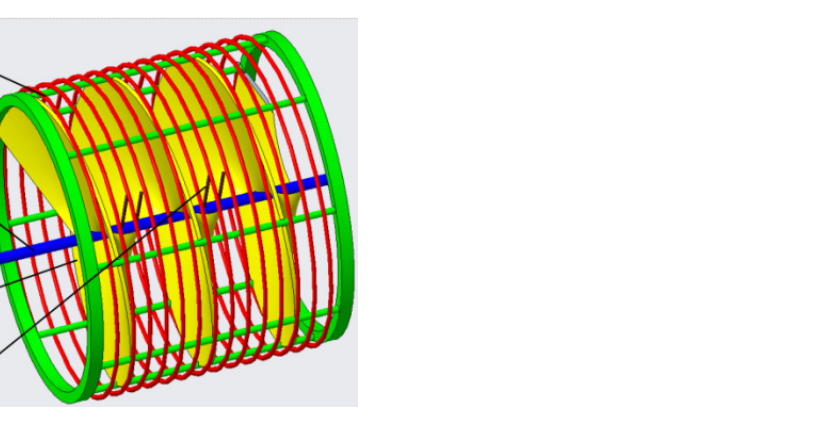
Figure 2. Flexible separation device for fruit–soil structure diagram. 1. Ring; 2. Drive shaft; 3. Spiral conveyor blade; 4. Broken soil roller.